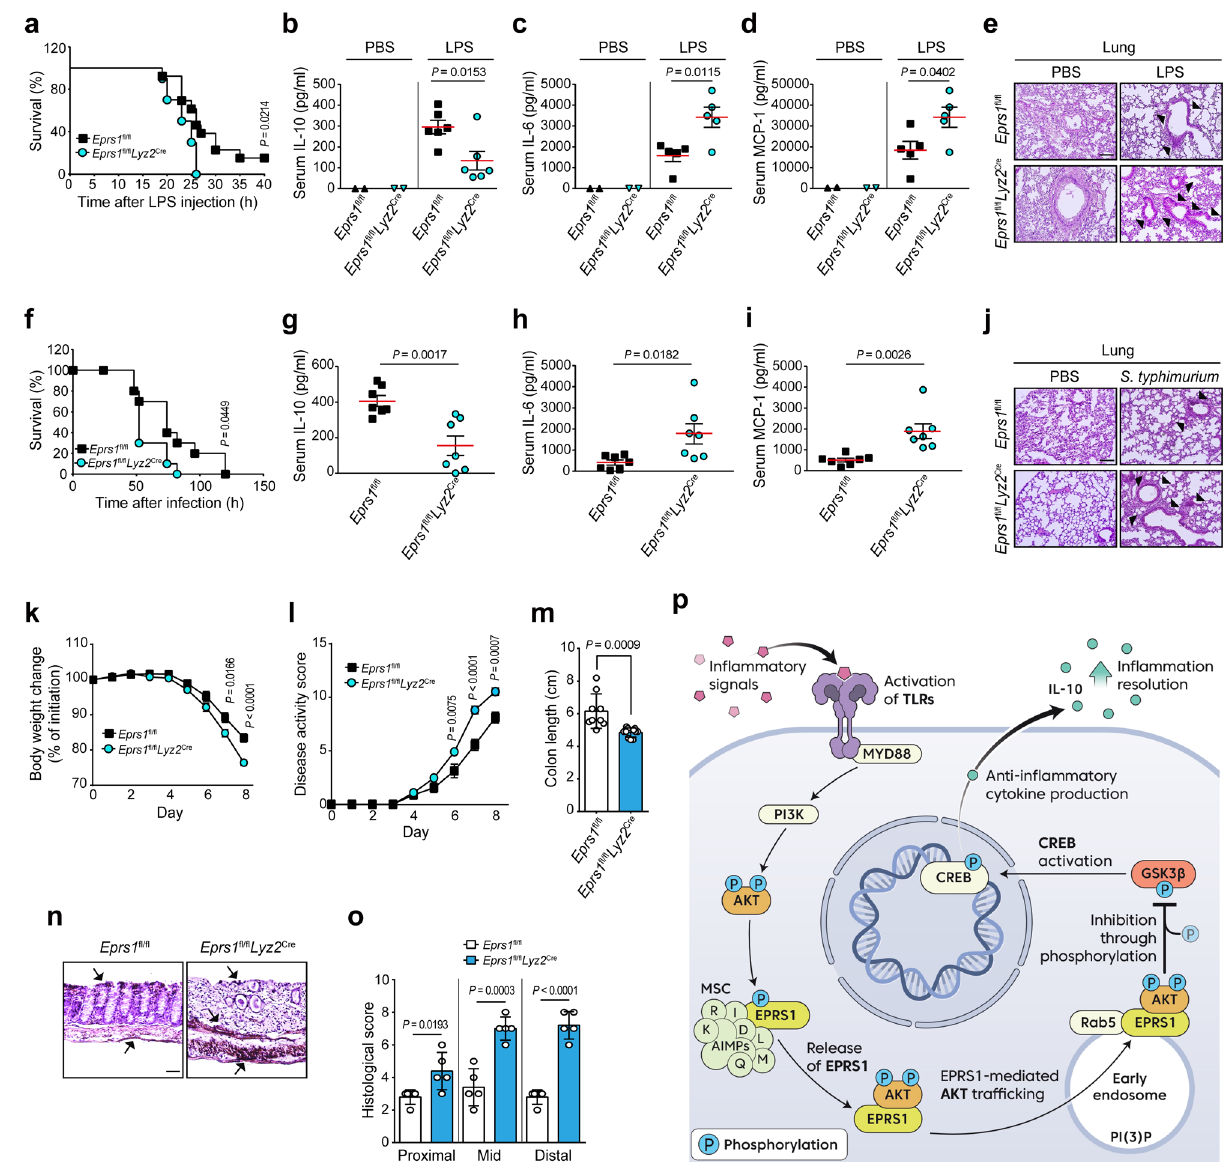
Fig.6|EPRS1protectsmicefromin fl ammatoryinsults.a Survivalratesof Eprs1 fl / fl ( n =13) and Eprs1 fl / fl Lyz2 Cre ( n =10) mice were examined following intraperitoneal injection of LPS (30mg/kg). b Serum concentrations of IL-10 in Eprs1 fl / fl ( n =6) and Eprs1 fl / fl Lyz2 Cre ( n =6) mice measured 6h after LPS injection. c , d Concentration of IL-6 ( c ) and MCP-1 ( d ) in Eprs1 fl / fl ( n =5) and Eprs1 fl / fl Lyz2 Cre ( n =5) mice serum, measured 24h after LPS injection. e Hematoxylin – eosin (H&E)-stained sections of lungtissuesfrom Eprs1 fl / fl and Eprs1 fl / fl Lyz2 Cre mice24hafterLPSinjection.Scalebar, 200 μ m. Black arrows indicate in fi ltration by in fl ammatory cells and thickened alveolar walls. f Survival rates of Eprs1 fl / fl and Eprs1 fl / fl Lyz2 Cre mice ( n =10 per group) were examined following intraperitoneal injection of S. typhimurium (5×10 7 cfu). g Serum concentration of IL-10 in Eprs1 fl / fl ( n =7) and Eprs1 fl / fl Lyz2 Cre ( n =7) mice, measured6hafter S.typhimurium infection. h , i ConcentrationofIL-6( h )andMCP- 1 ( i ) in Eprs1 fl / fl ( n =7) and Eprs1 fl / fl Lyz2 Cre ( n =7) mice serum, measured 24h after S. typhimurium infection. j H&E-stained sections of lung tissues from Eprs1 fl / fl and